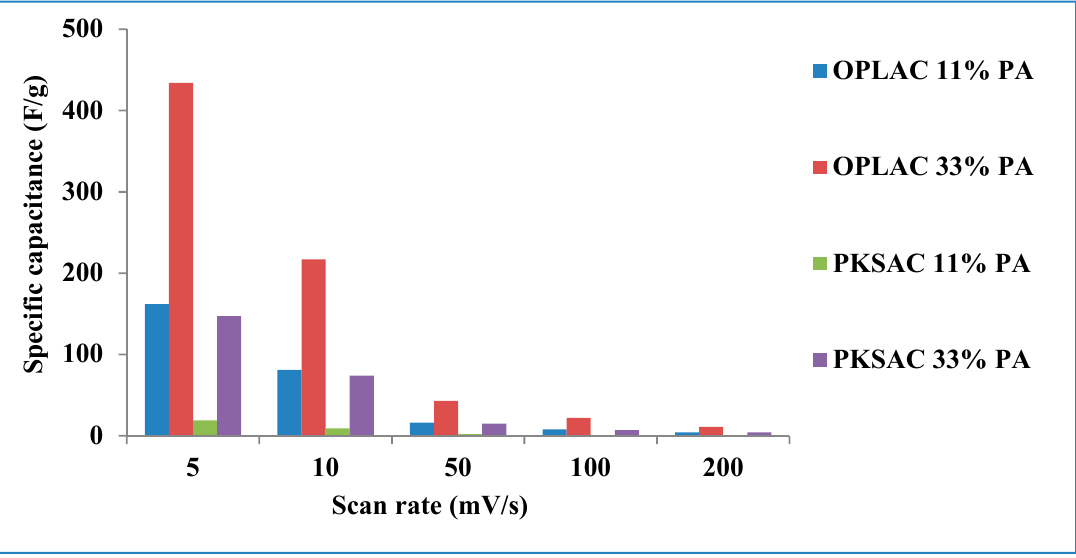
Figure 12. The specific capacitance, measured at different scan rates, of the different activated carbon samples derived from the two precursors.